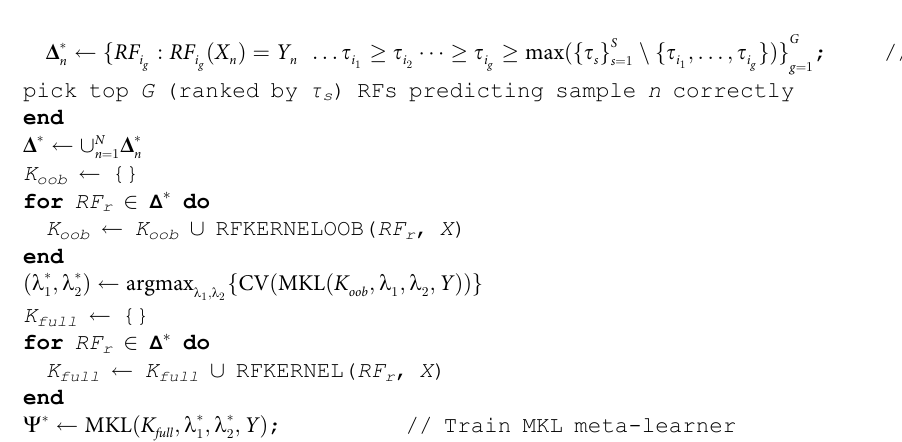
Algorithm 1 can filter the full collection of feature sets down to a subgroup of relevant sets two or more orders of magnitude smaller in size. This makes it possible to incorporate